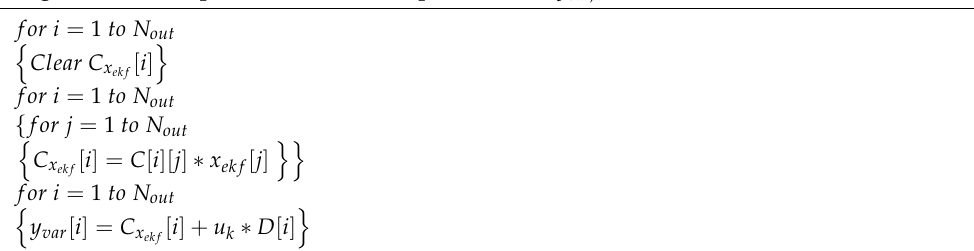
Algorithm 3: Compute the standard output function , y var,k